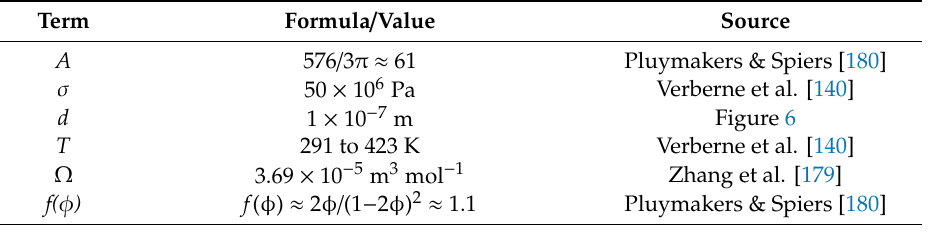
Table 3. Values / expressions used for the terms appearing in Equation